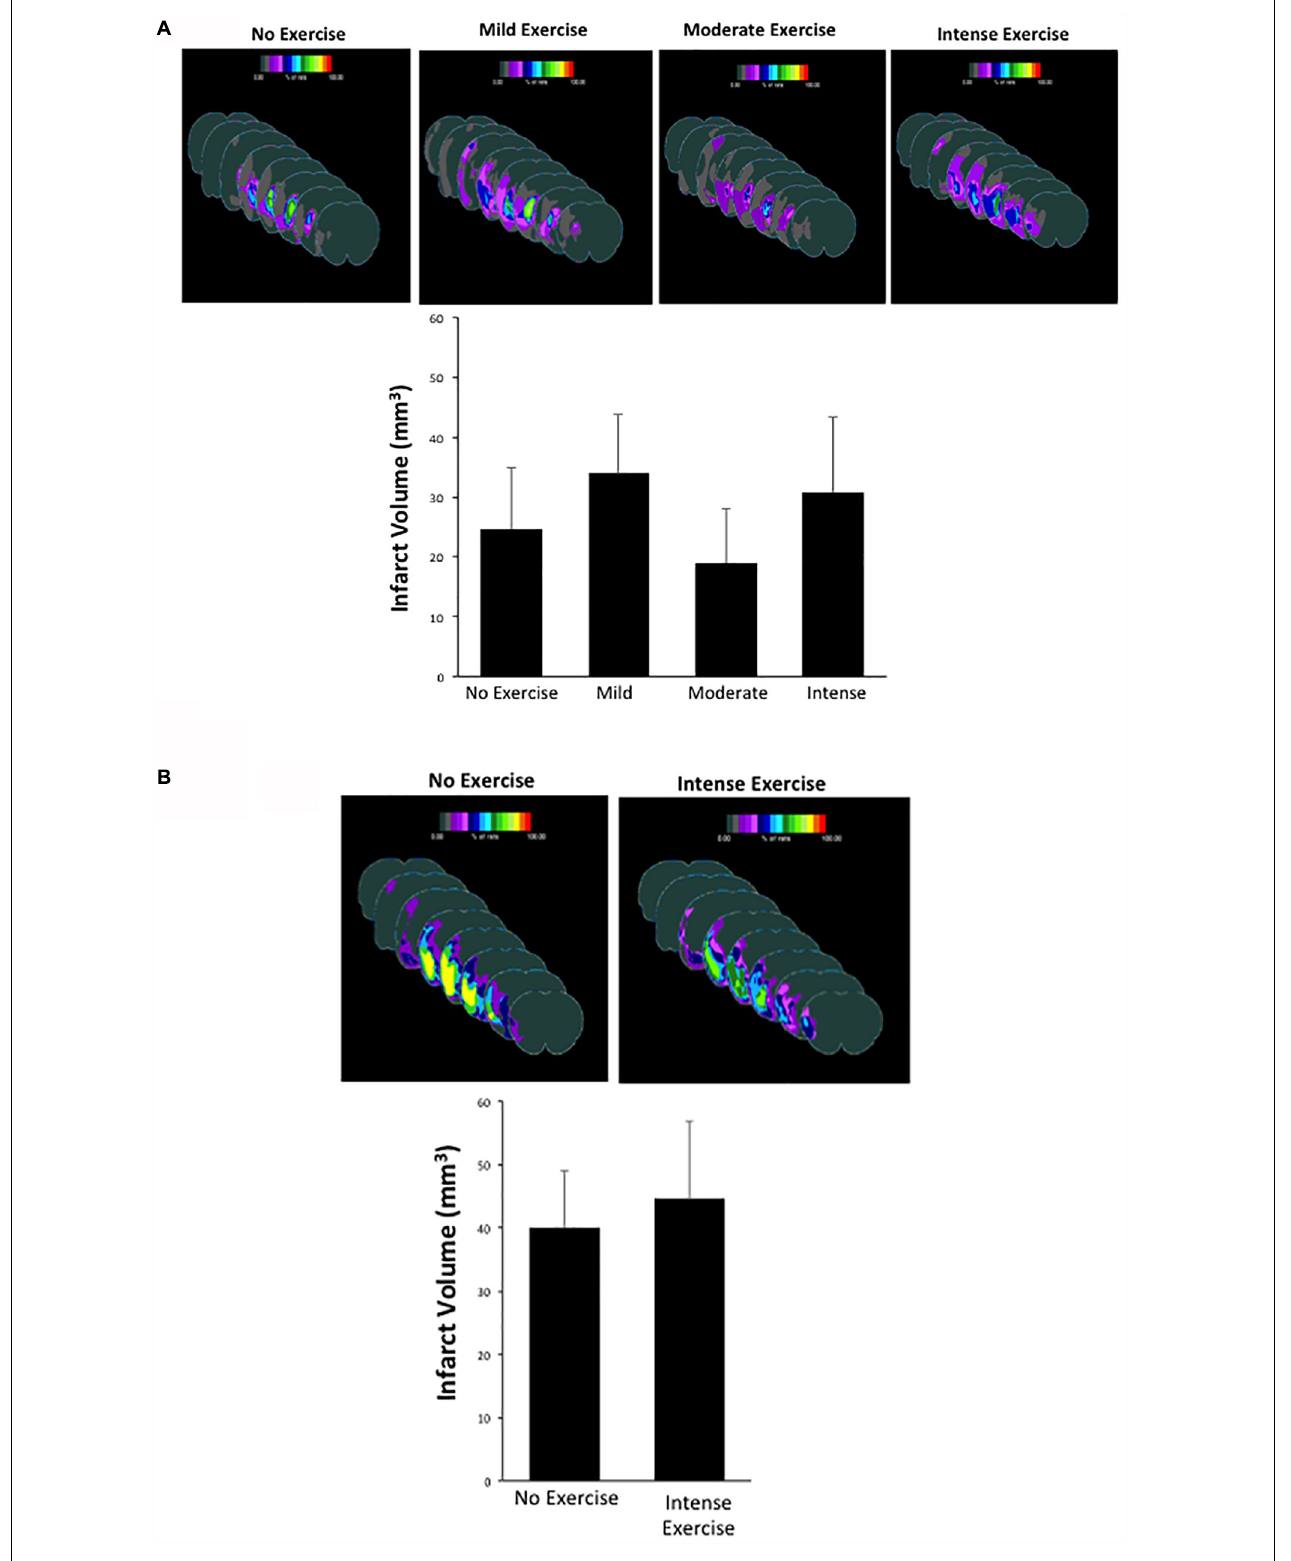
FIGURE 3 | (A,B) Infarct volume measurements observed in male and female rats that had undergone different exercise intensities following recovery from MCAO. There were no significant differences observed between groups (one way ANOVA, Bonferroni post hoc test).